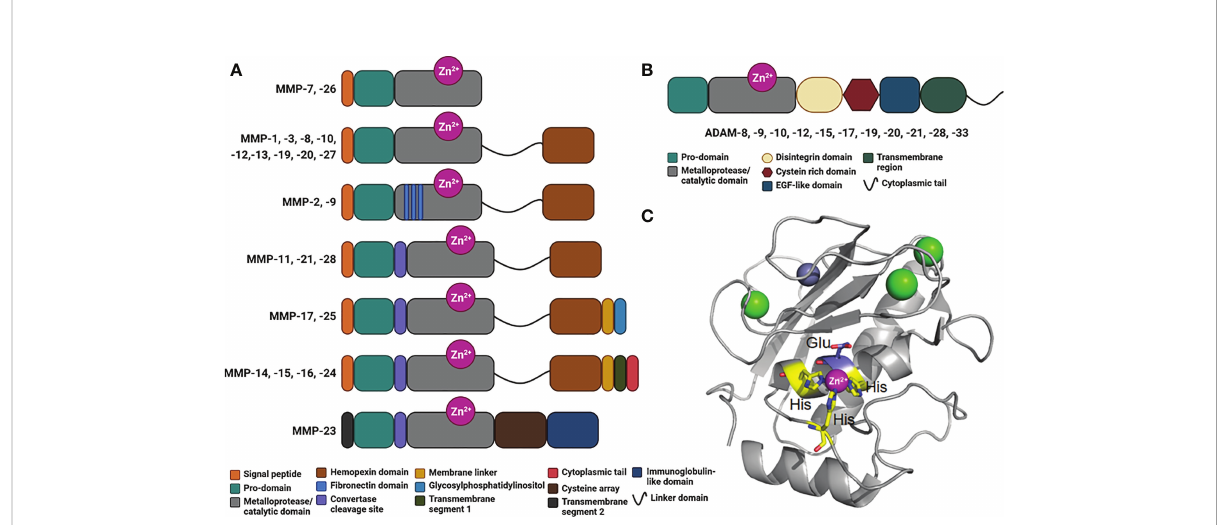
FIGURE 2 Domains in human MMPs and ADAMs. (A) Schematic representation of the domains in human MMPs consisting in a signal peptide, a prodomain, a metalloprotease/catalytic domain, a linker domain, a hemopexin domain, fi bronectin inserts, a convertase cleavage site, a membrane linker, a glycosylphosphatidylinositol, a transmembrane segment 1, a cytoplasmic tail, a transmembrane segment 2, a cysteine array and immunoglobulin-like domain. (B) Schematic representation of ADAMs organized in modules consisting in a prodomain, a metalloprotease/ catalytic domain, a disintegrin domain, a cysteine rich domain, an EGF-like domain, a transmembrane region and a cytoplasmic tail. (C) Crystal structure of a typical Metalloprotease/catalytic domain in cartoon representation (hMMP-12, PDB code: 4GQL), with catalytic zinc ion as magenta ball, His residues chelating the catalytic zinc ion in yellow stick, catalytic glutamic acid residue in blue stick, and structural zinc and calcium ion as grey and green balls,